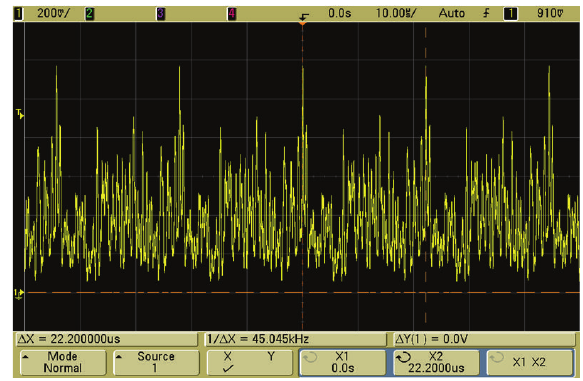
Figure 8: For 10 𝜇 s frequency exponential model.